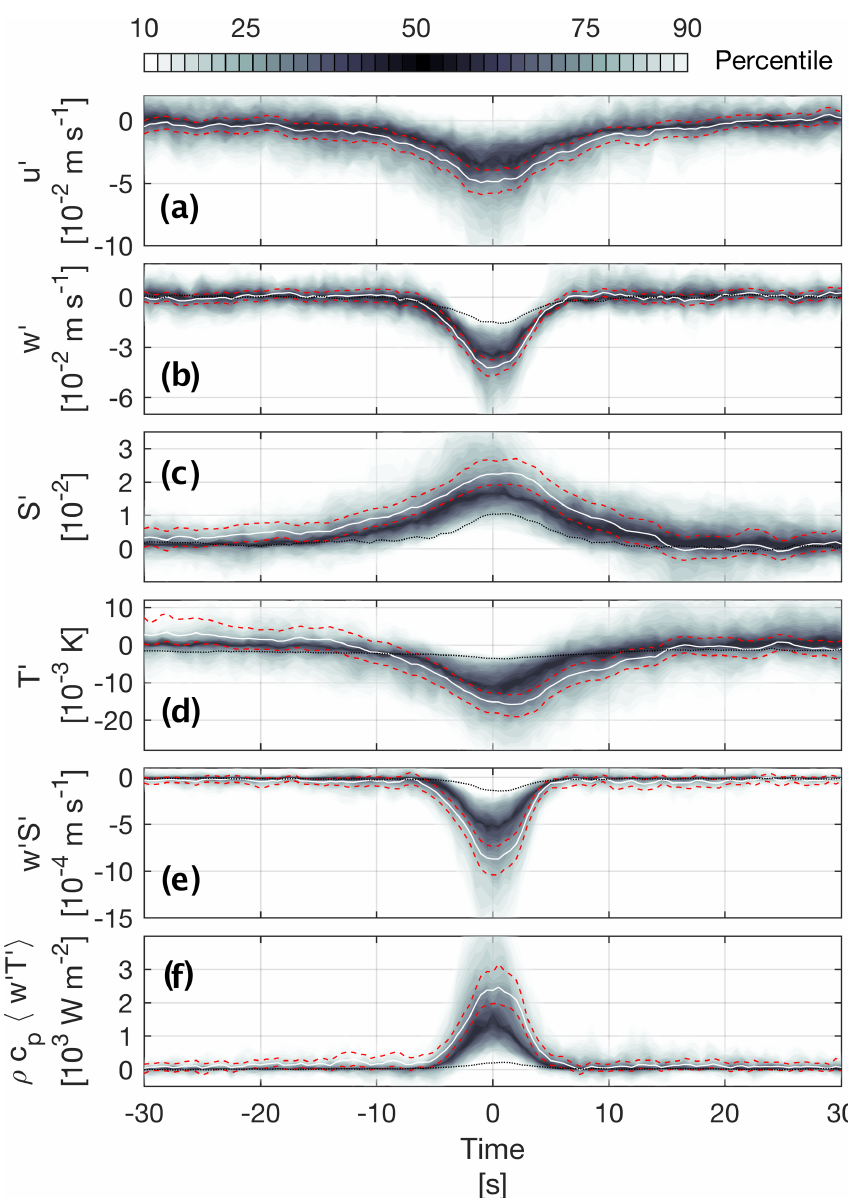
Figure 5. Composite of 131 plumes identified using the peak in (cid:104) w (cid:48) S (cid:48) (cid:105) and presented in a 60s window. Spread in the data is shown as percentiles (shading) overlain by the mean (white) and its 95% confidence interval from bootstrap calculations (dashed red). Variables are fluctuations of (a) horizontal and (b) vertical velocity, (c) salinity, (d) temperature, and turbulent fluxes of (e) salt and (f) heat. The results from Widell et al. (2006) are shown for reference (black dotted